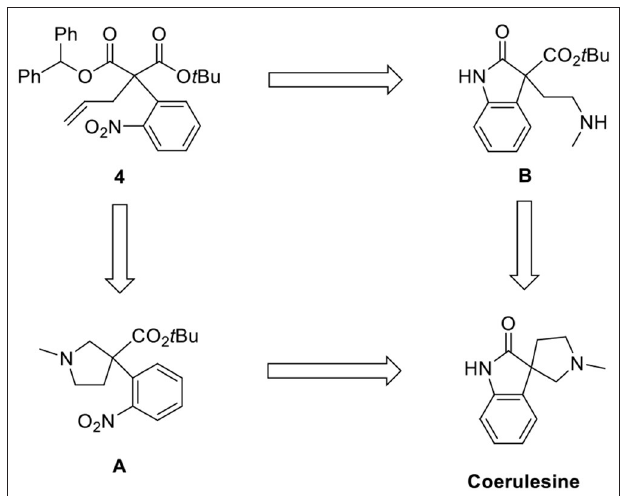
SCHEME 2 | Retrosynthetic